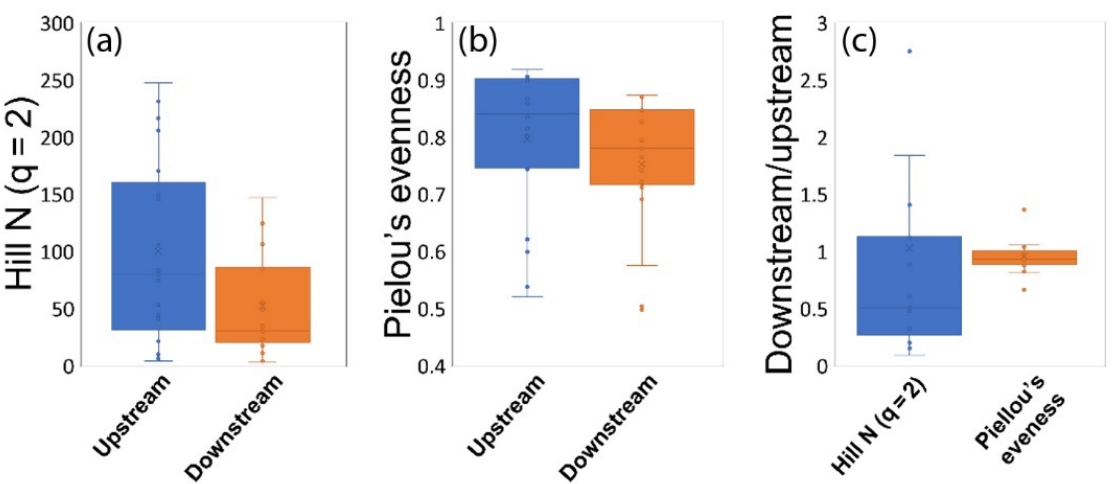
Figure 3. Box plots showing ( a ) Hill N (q = 2) (effective species numbers) as a measure of upstream and downstream alpha diversity; ( b ) upstream and downstream Piellou’s evenness; and ( c ) the site and time specific downstream/upstream ratio between the measures in panels ( a , b ). A value lower than 1 represents a decrease in the downstream sample.